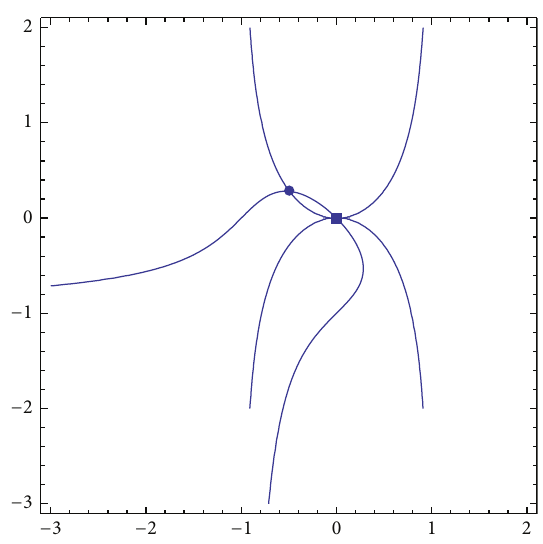
Figure 3: Real part of 𝑓(𝑥,𝑦) = 0 in Example